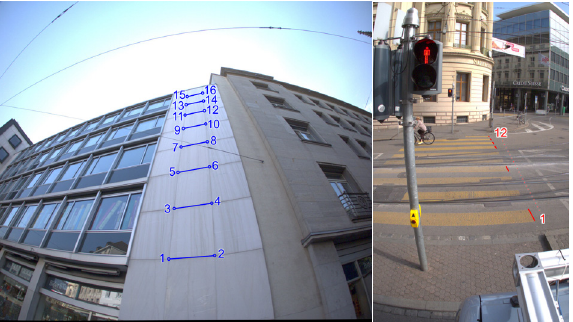
Figure 7. Layout of reference distances for the accuracy analysis (left: architecture use case, right: road infrastructure use case)